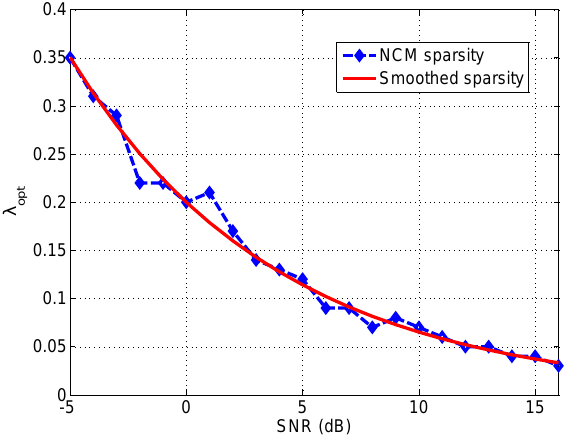
Figure 4. Plot of the optimum lambda values as a function of the signal-to-noise ratio (SNR) value. The blue dashed line shows the optimum values obtained by calculating the NCM of vocoded speech samples after being processed according to the sparse NMF strategy, using the Bamford-Kowal-Bench (BKB) database. The red solid curve corresponds to the fitted optimum λ values based on an exponential decay